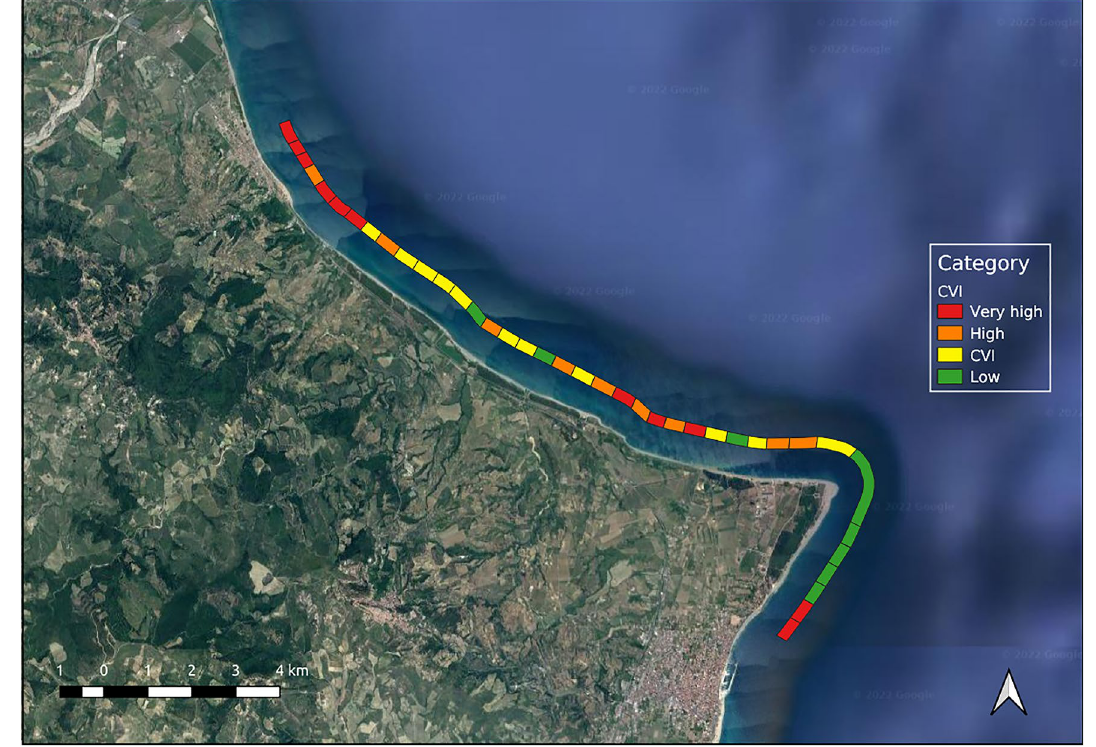
Figure 5. CVI category for each transect. The map was created using QGIS 3.29 software (https:// qgis. org).